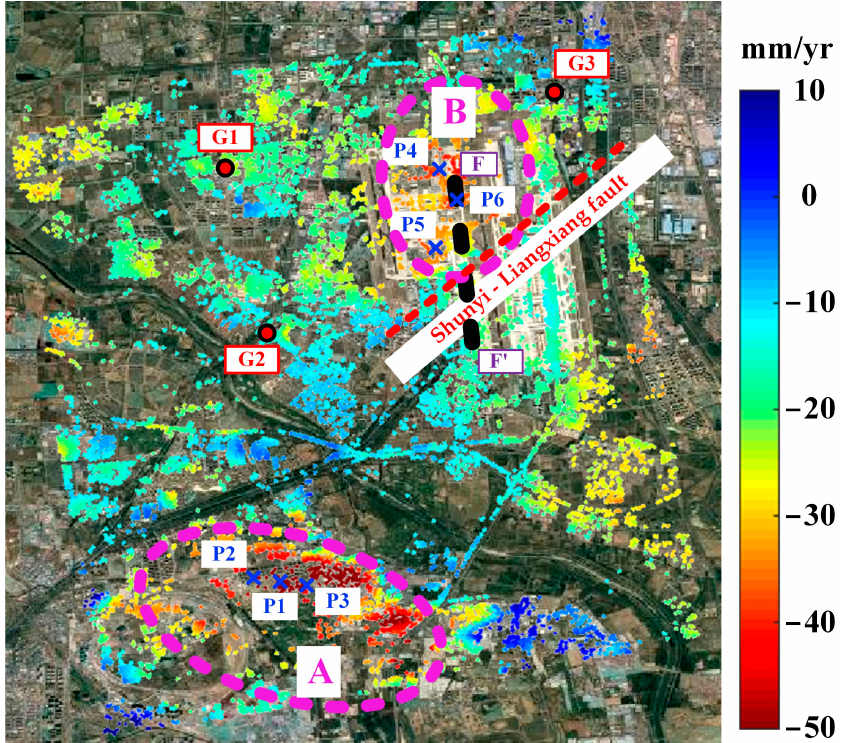
Figure 8. Locations of the ground-monitoring wells and ground benchmarks with the mean velocity map as background (Areas A and B were two typical subsiding areas; F-F ′ is Shunyi-Liangxiang fault; G1–G3 is the position of three benchmarks; P1–P6 represent six feature points.). Table 1. Correlation coefficients between the deformation obtained by the three methods and the groundwater level. Points